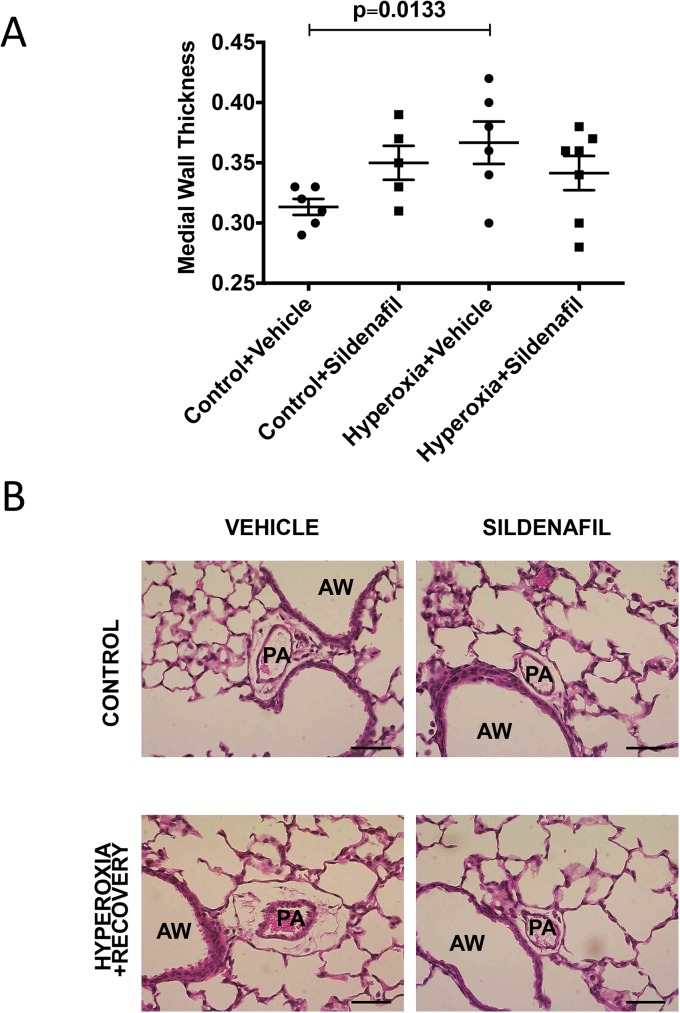
Sildenafil treatment during recovery does not ameliorate increased MWT associated with neonatal hyperoxia exposure.Mice were exposed to hyperoxia or room air for 14d, followed by recovery in room air for an additional 7d ± sildenafil or vehicle. (A) H&E stained sections were imaged, and MWT was measured as the ratio of the small PA wall area over total PA area (n = 6–7 animals per group). (B) Representative H&E-stained lung sections are shown for vehicle-treated control, vehicle-treated hyperoxia + recovery, sildenafil-treated control, and sildenafil-treated hyperoxia + recovery. Bar = 50 μm. Data are expressed as dot plots with each dot representing individual animals with means and SEM represented by horizontal lines. Results were analyzed by ANOVA with post-hoc Bonferroni’s analysis. PA = Pulmonary Artery, AW = Airway.